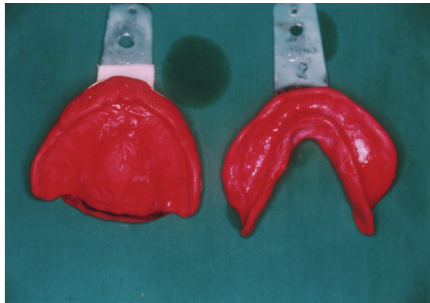
Figure 5: Posterior teeth at occlusion.